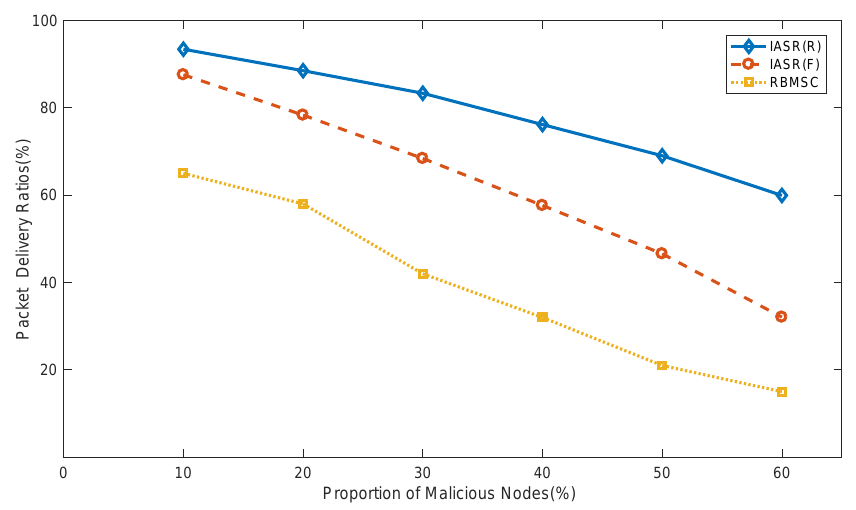
Figure 7. Comparison of packet delivery ratios in two models for different numbers of malicious